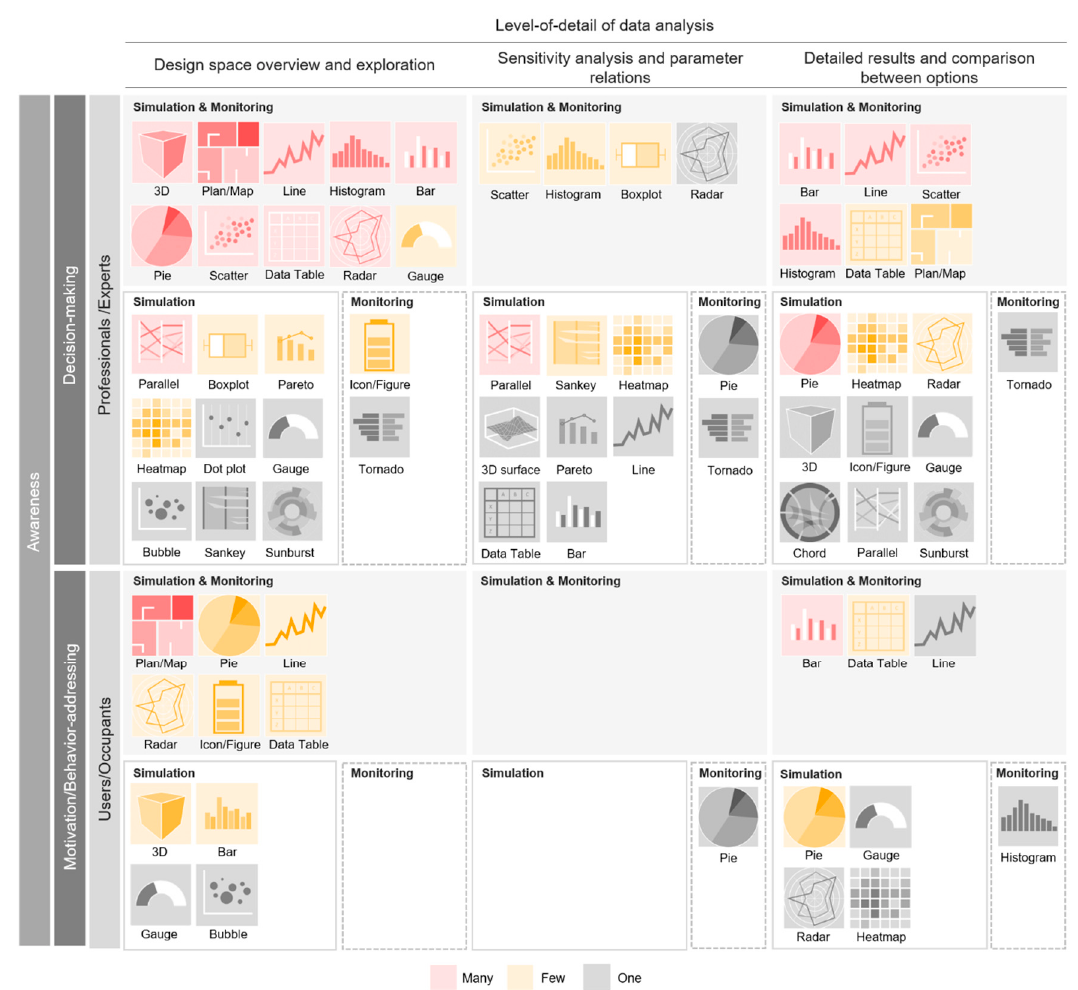
Figure 7. Graphical representations per type of building energy and level of detail of data analysis in relation to users.